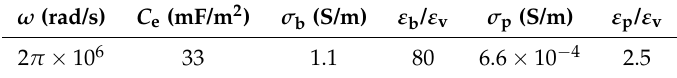
Table A2. Parameter values used in the finite element